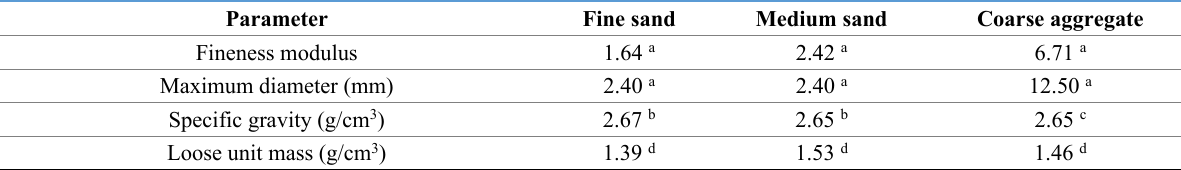
Table 1. Physical characterization of the